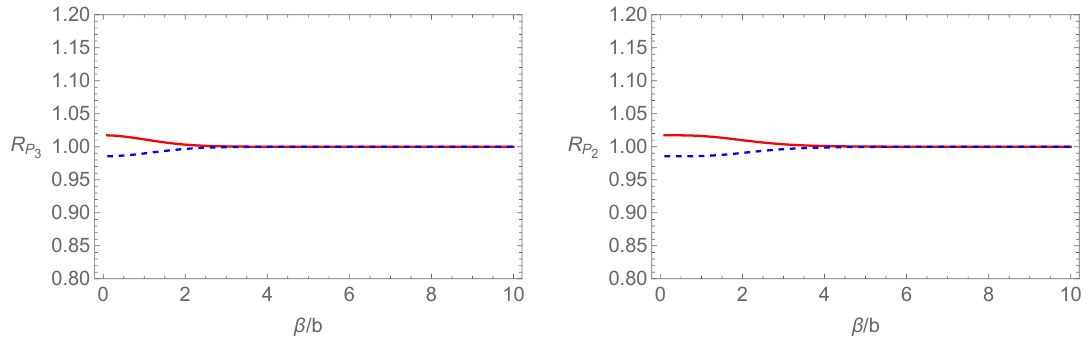
(left plot) and R (right plot) in (3.26). The upper (red) solid lines Figure 2. The ratios R P P 2 3 correspond to the bosonic case, while the lower (blue) dashed line to the fermionic